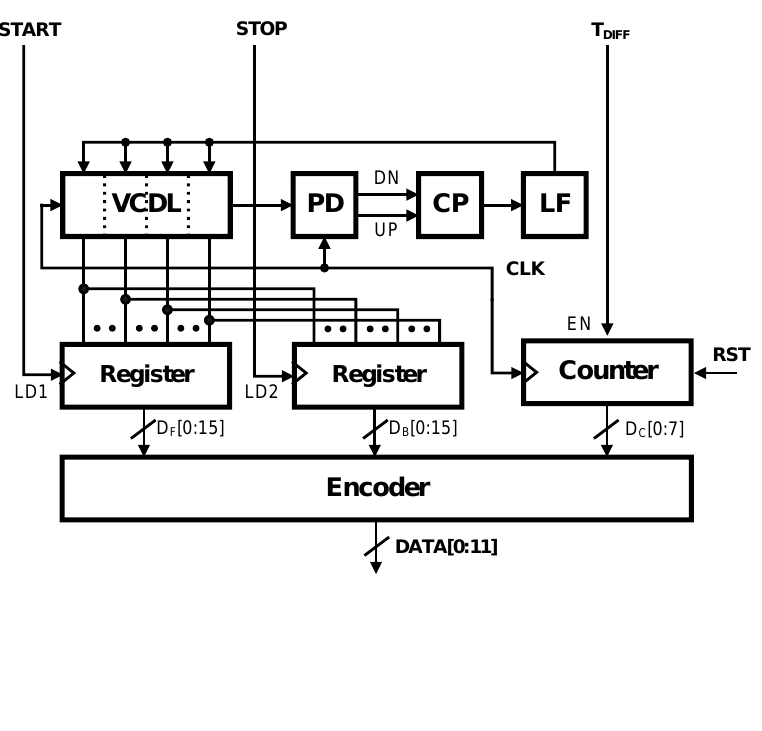
Figure 9. Analog to digital TDC circuit in the CNT ROIC.